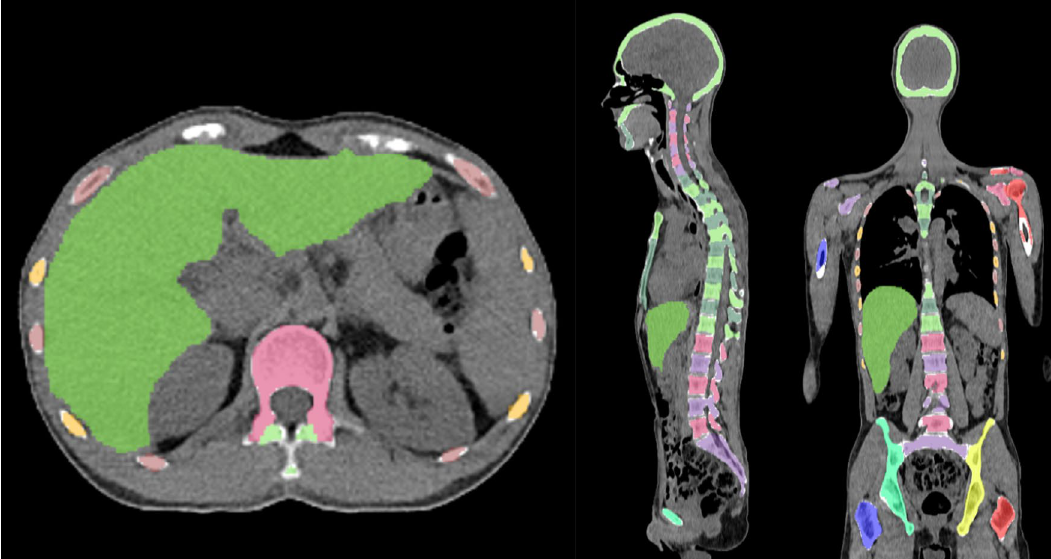
Figure 1. CT: Example of bone and liver segmentations performed by the artificial intelligence-based